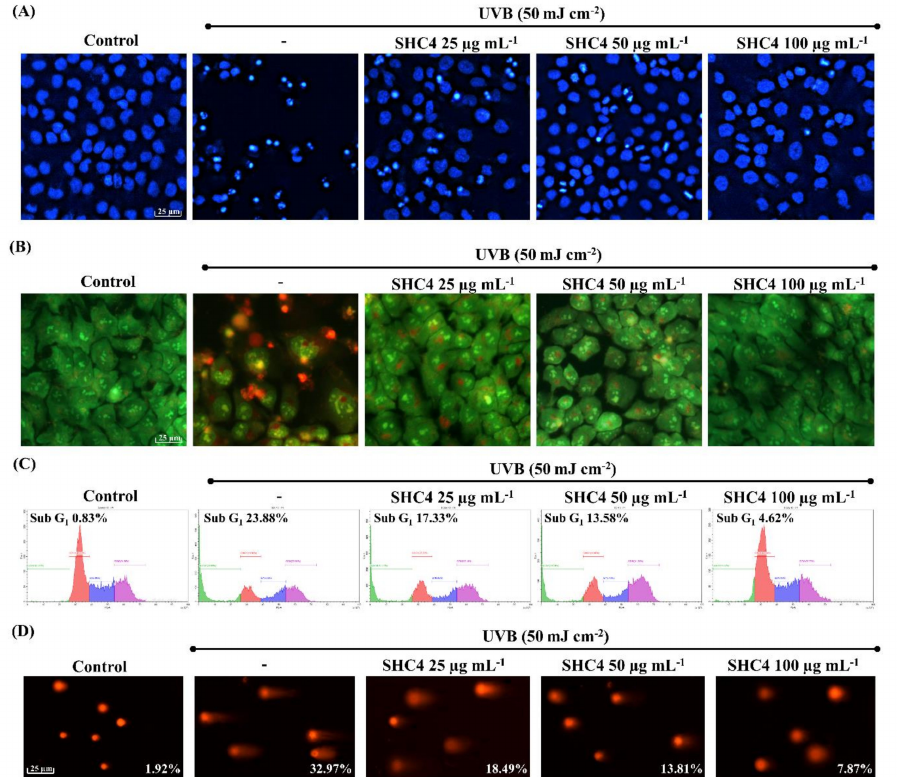
Figure 5. E ff ects of SHC4 on ultraviolet B (UVB)-induced apoptotic body formation and DNA damage. Nuclear morphology analysis of apoptotic body formation by ( A ) Hoechst 33342 and ( B ) nuclear double staining with ethidium bromide and acridine orange. ( C ) Cell cycle analysis of Sub-G 1 apoptotic cell accumulation. ( D ) Analysis of DNA damage by comet assay. Comet-tail DNA contents were quantified using OpenComet plugin in ImageJ software. HaCaT cells were treated with di ff erent doses of polysaccharide fractions for 2 h and exposed to UVB radiation. Cells were harvested for experiments 1 h after UVB exposure. Repeatability of results was validated with three independent determinations ( n =